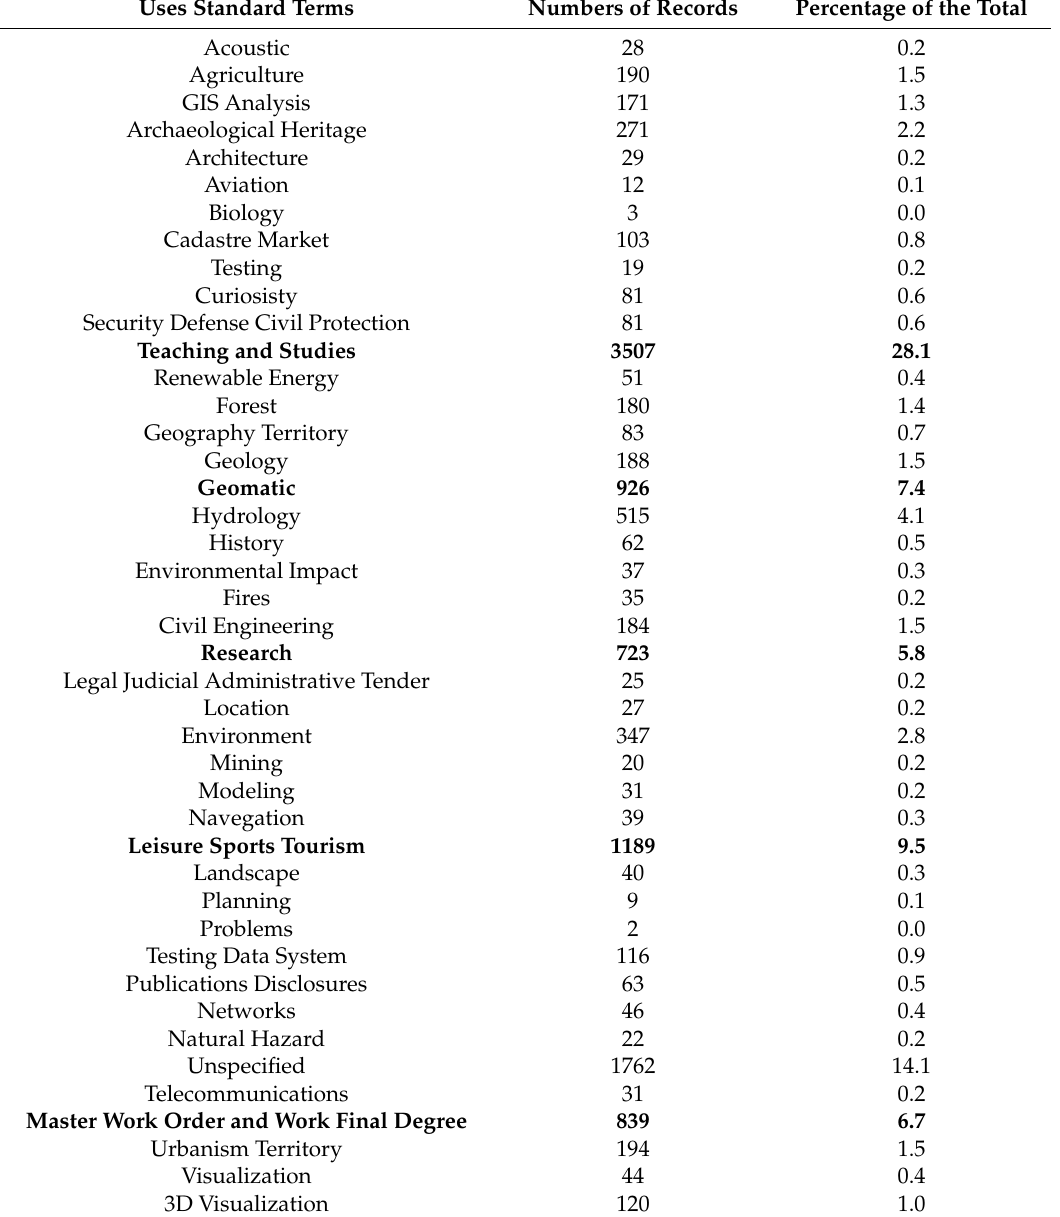
Table 8. Downloads of DEMs regarding the Description of use for which they are intended. Uses Standard